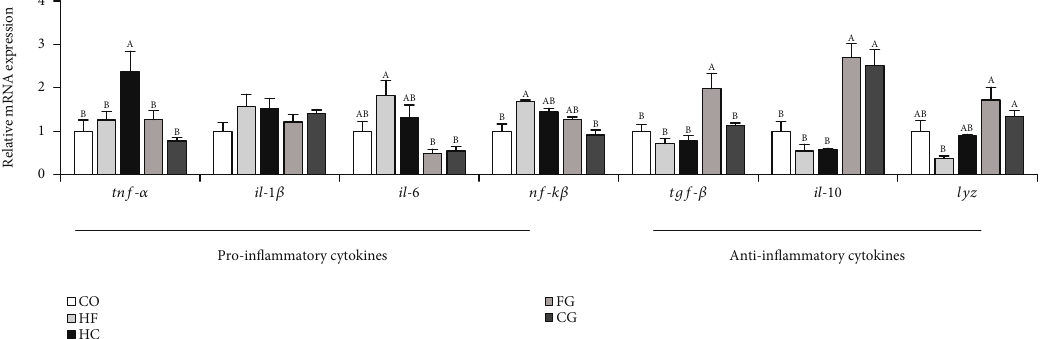
Figure 6: Expressions of immune-related genes in the head kidney of common carp fed di ff erent experimental diets. Values are means ± S : E : per diet in triplicate tanks ( n = 6 ). The di ff erent letters indicate di ff erences between diets (one-way ANOVA, Duncan ’ s test, P < 0 : 05 ).